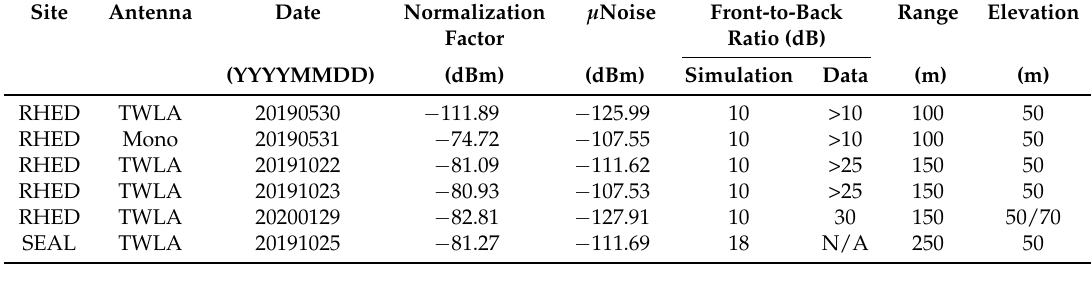
Table 3. Drone pattern measurement results summary for pattern measurements performed at RHED and SEAL HFR stations. TWLA identifies the directional antenna. The initial installation at RHED was directed 60 ◦ from the baseline towards SEAL which is the centre of the optimal sea coverage area of the two sites. It was subsequently decided that for future coverage to the south and to reduce the signal directed overland to the north that the directionality should be directed 90 ◦ to the baseline.